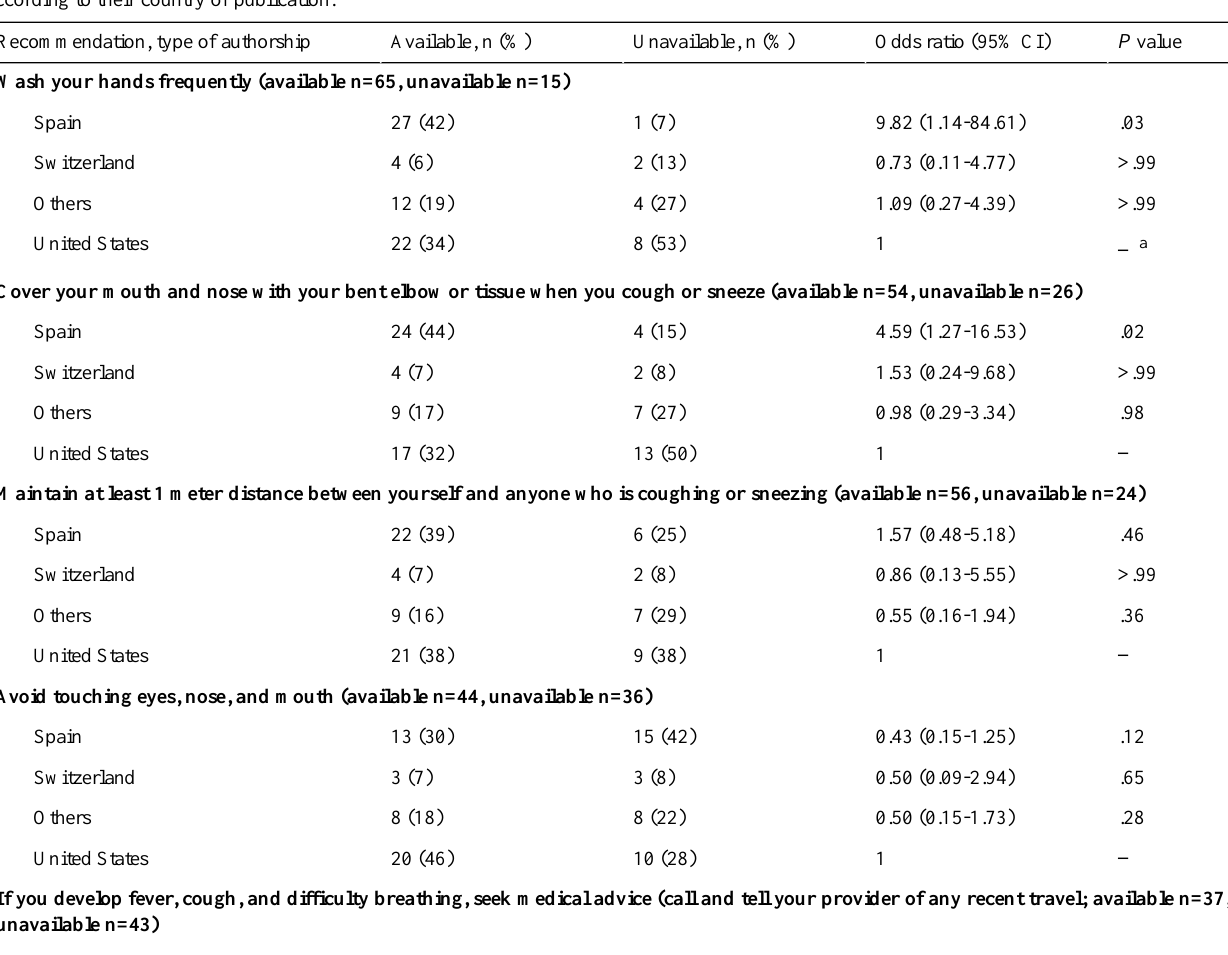
Table 3. Recommendations to avoid COVID-19 according to the World Health Organization and information about them available on the internet according to their country of